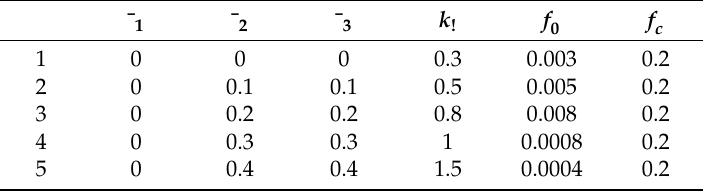
Table 2. The parameters and the